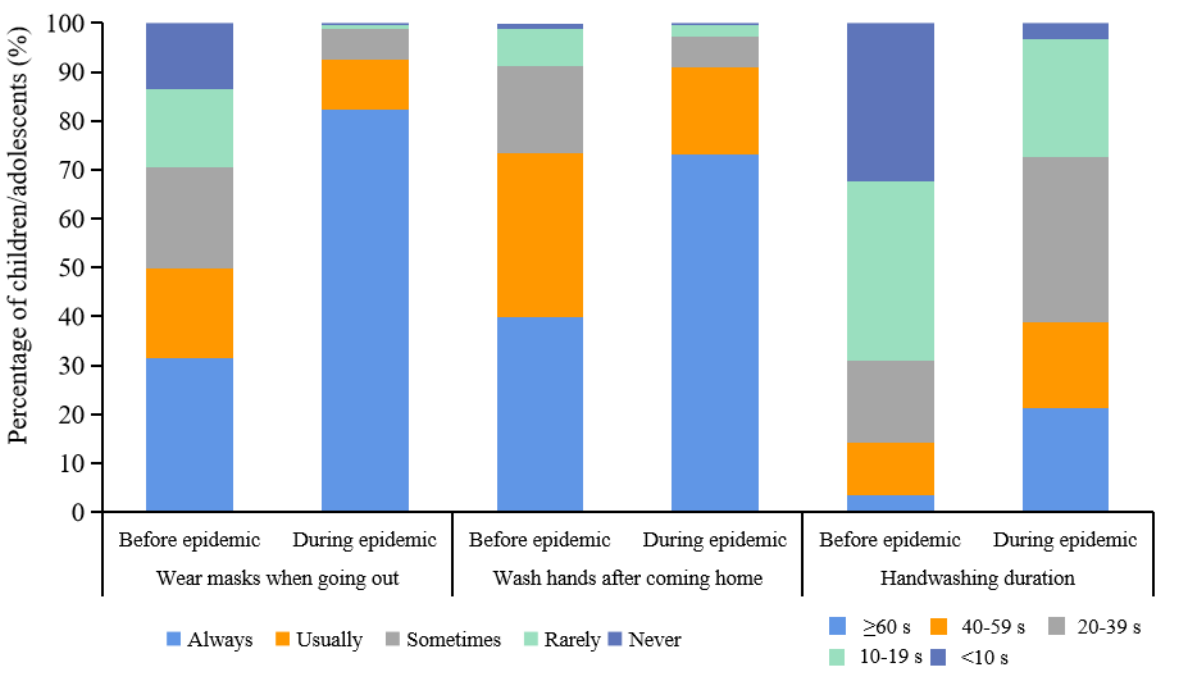
Figure 1. Comparison of prevention behaviors among children and adolescents in Wuhan and Shanghai before and during the COVID-19